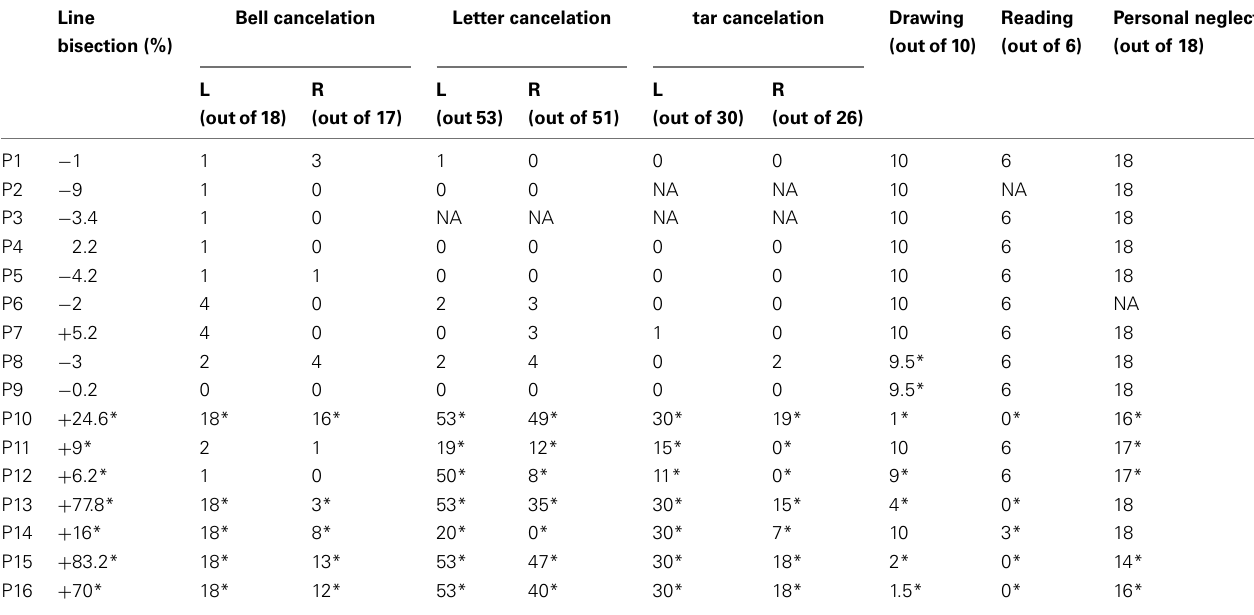
Table 2 |Assessment for visuo-spatial